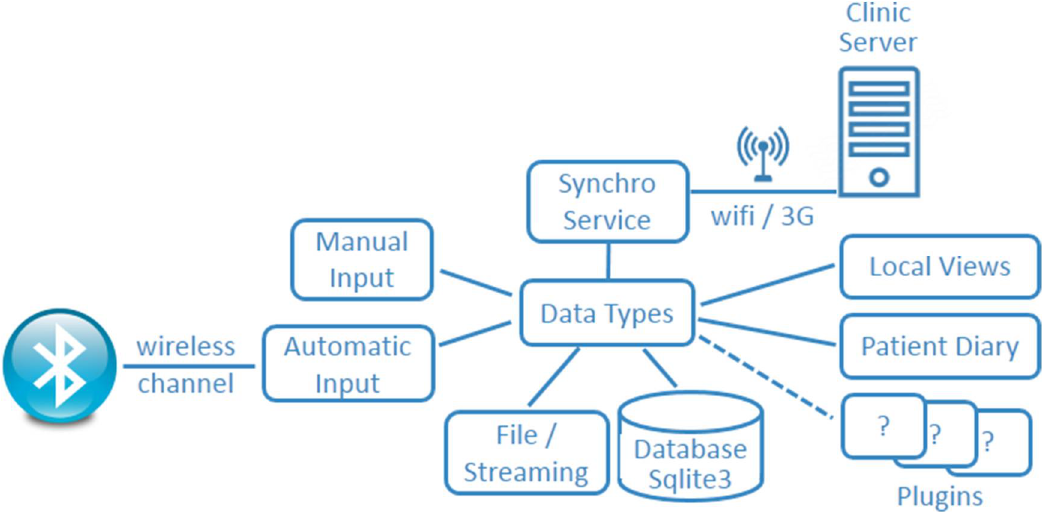
Figure 7. The computational architecture of the remote monitoring service used by Telefetalcare.